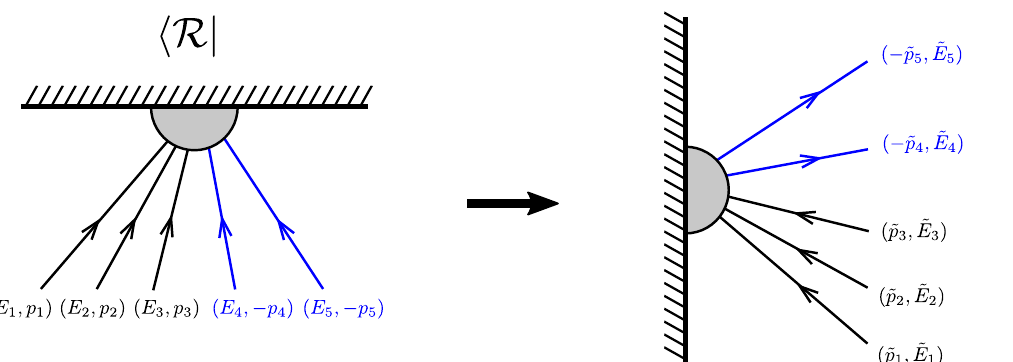
Figure 16 . The relation between the form factor and the re(cid:13)ection matrix. In order to relate the two, we perform the double-Wick rotation, and appropriate crossing transformations which map particles with negative energy to the out state. As a result, we obtain a process in which particles get scattered o(cid:11) a